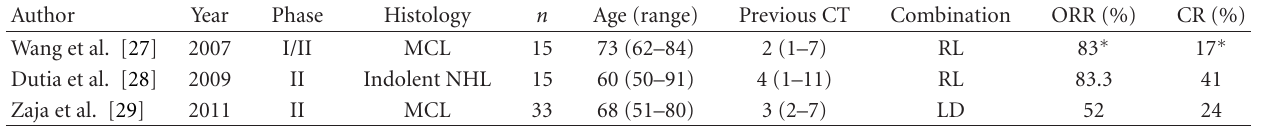
Table 3: Lenalidomide containing regimens in relapsed/refractory indolent and mantle cell lymphoma.